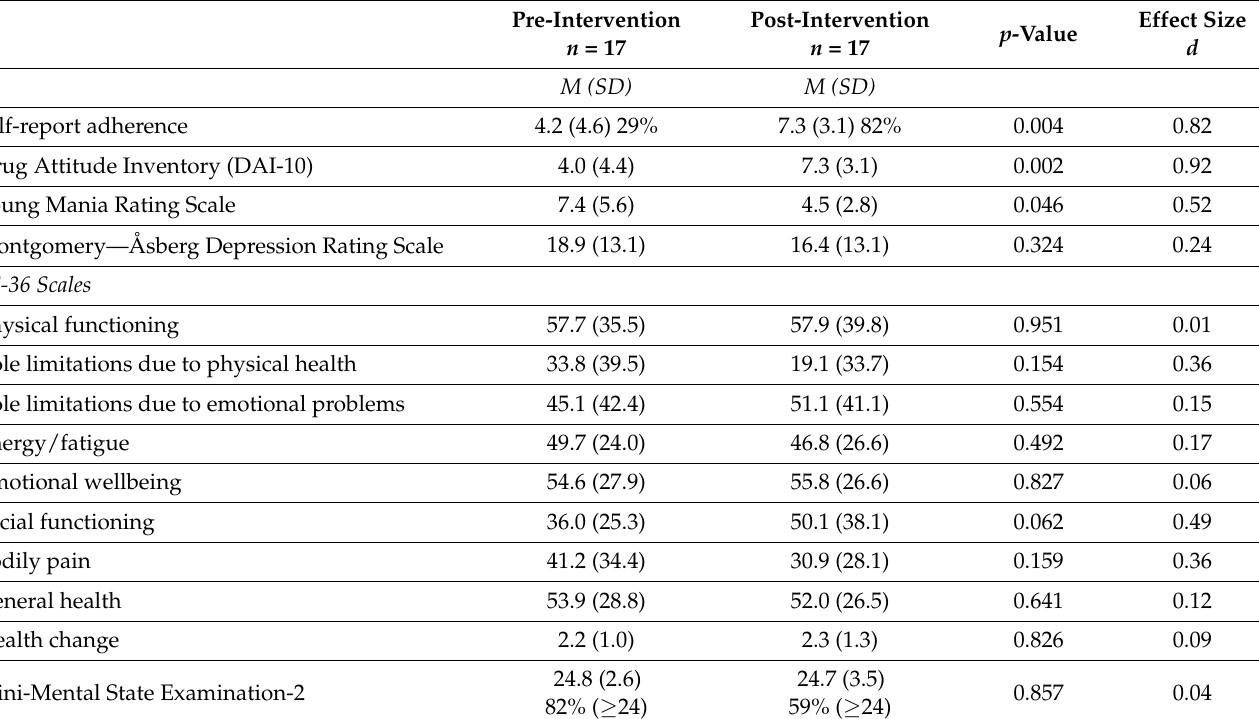
Table 4. Pre- and post-treatment scores of those who completed the